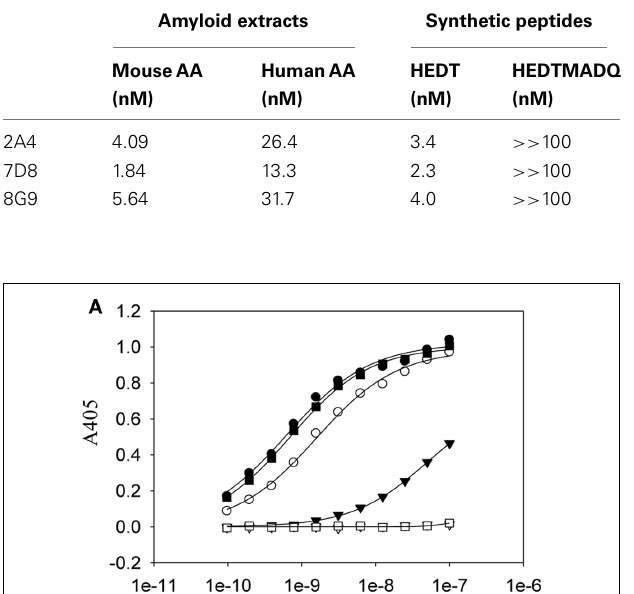
• ◦ , HEDT; , AEDT; (cid:2) , HADT;